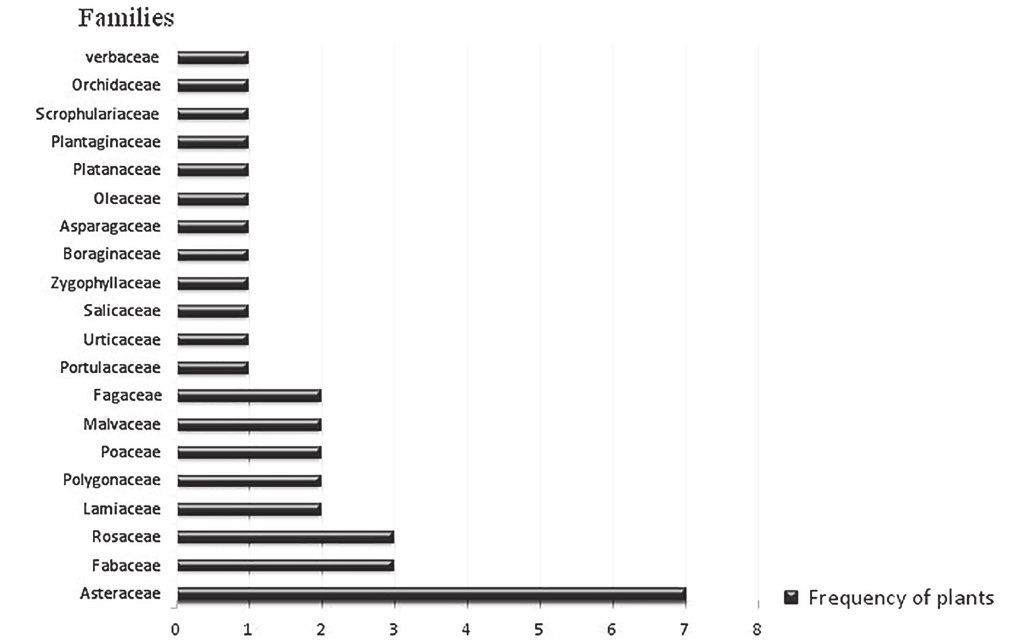
FIGURE 2 - Families of the plants with their